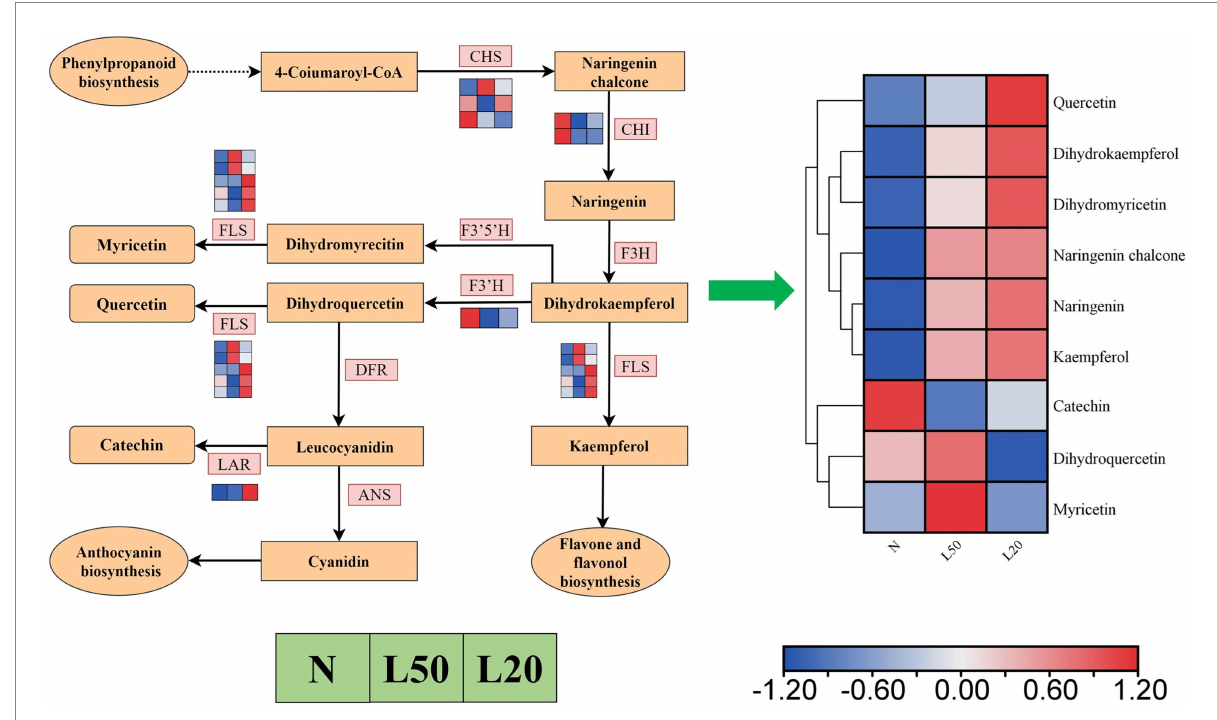
FIGURE 11 The expression of genes in the flavonoid biosynthetic pathways of J. mandshurica under shade. Reconstruction of the flavonoid biosynthetic pathway with the differentially expressed structural genes and the differentially accumulated metabolites (DAMs) in the flavonoid biosynthetic pathway. The color scale from Min (blue) to Max (red) refers to the metabolite contents from low to high. The cluster marker on the right side of the heatmap represents the names of each metabolite. N: natural sunlight. L50: 50% sunlight to go through. L20: 20% sunlight to go through. CHS, chalcone synthase; CHI, chalcone isomerase; F3H, naringenin 3-dioxygenase; FLS, flavonol synthase; F3’5’H, flavonoid 3 ′ ,5 ′ -hydroxylase; F3’H, flavonoid 3 ′ -monooxygenase; FLS, flavonol synthase; DFR, bifunctional dihydroflavonol 4-reductase/flavanone 4-reductase; ANS, anthocyanidin synthase; LAR, leucoanthocyanidin